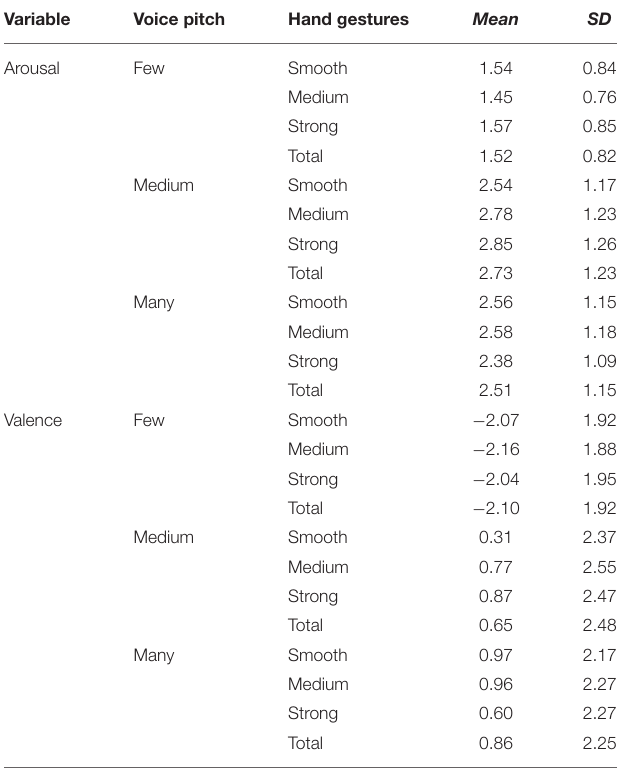
TABLE 2 | Self-reported arousal and valence of voice pitch and hand gestures. Variable Voice